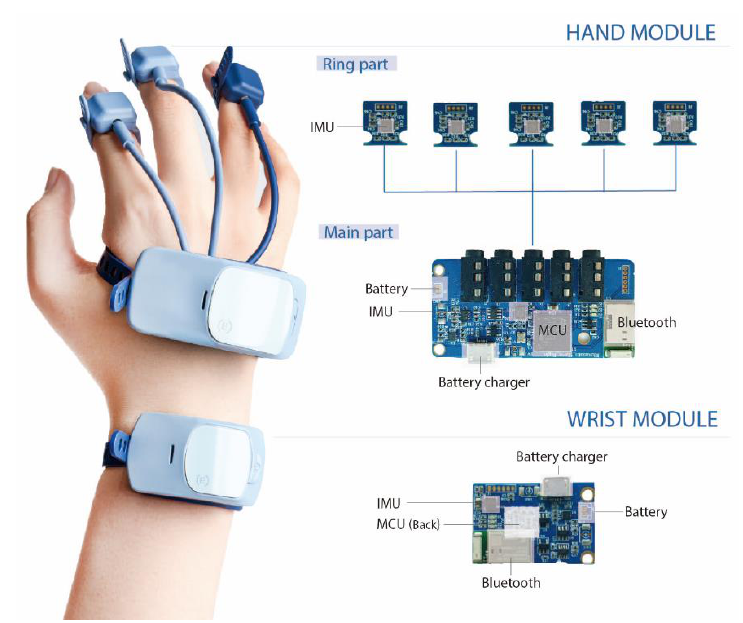
Figure 2. System architecture: the hand and wrist modules.